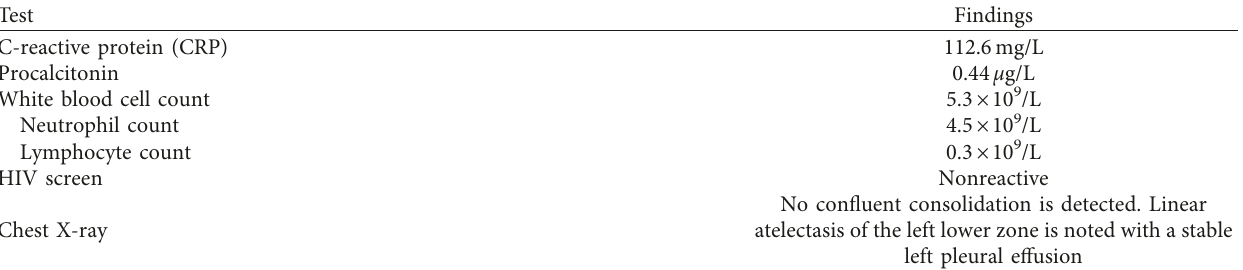
Figure 1: Patient’s right forearm cellulitic skin changes and bullae on admission. Table 1: Investigations on day 1 of